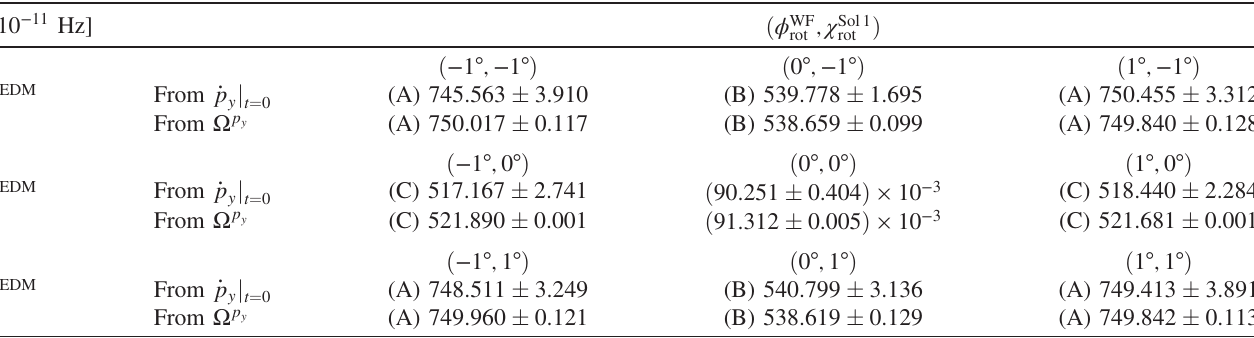
TABLE VI. Resonance strengths extracted from Fig. 19 for nine different combinations ð ϕ WF assuming a deuteron EDM of d ¼ 10 − 20 e cm [for (b), at (0°, 0°), d ¼ 10 − 17 e cm]. The beam conditions are given in Table I using the real field magnitudes of the rf Wien filter, since f has been divided out. For the calculations n ampl ¼ 10 5 . According to the equalities of Eq. (110), within the errors, the sets of numbers with markers (A), (B), except for (b), where n turns and (C) should